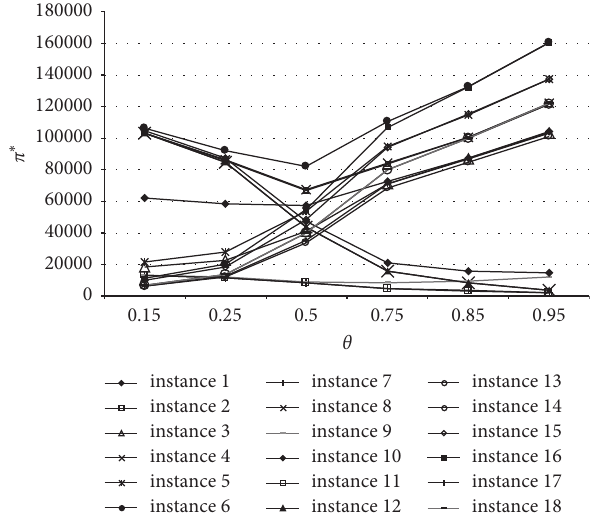
Figure 7: Supply chain profit in the centralized dual-channel supply chain for different